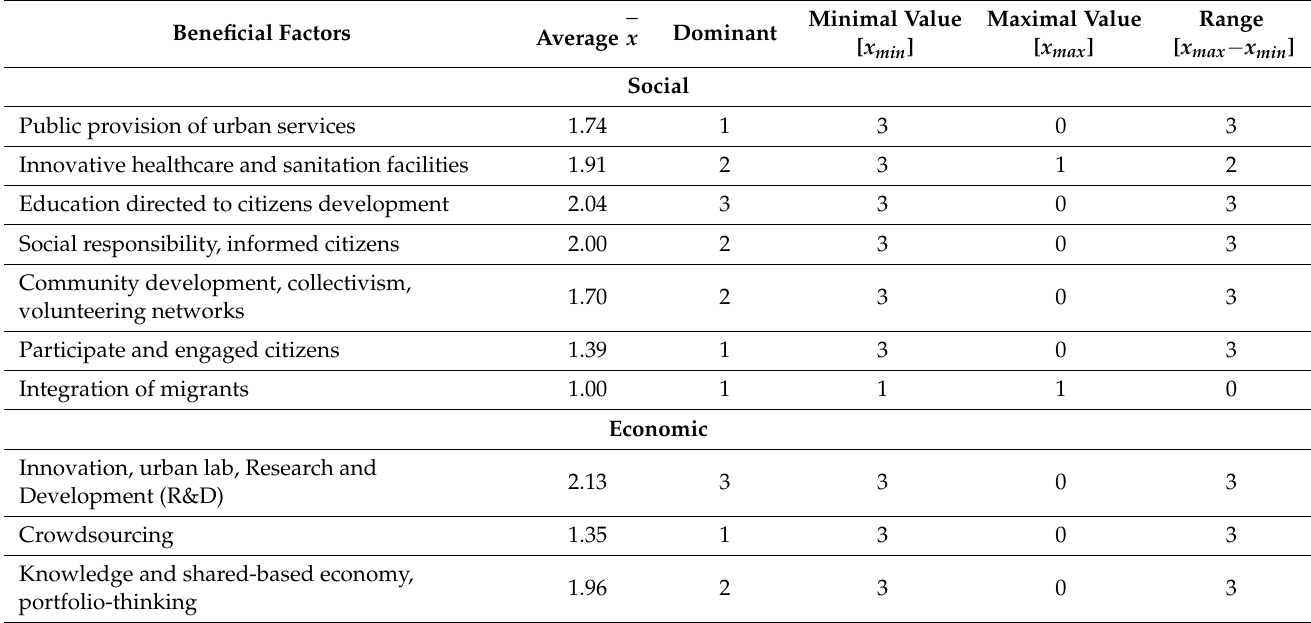
Table A2. Calculations of the descriptive statistics of the beneficial factors of a smart city in Poland based on expert opinion. Source: Own